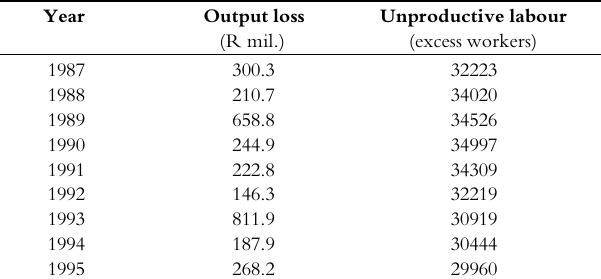
TABLE 2 NON-OPTIMALUTILISATION OF